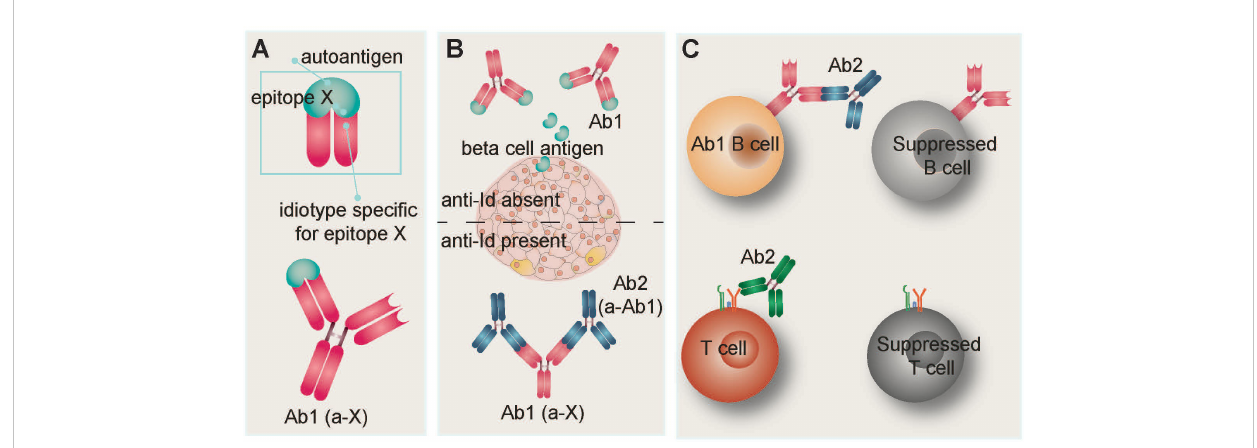
FIGURE 3 Idiotypic/anti-idiotypic network hypothesis. (A) The antigen binding site of an antibody is referred to as the idiotope. Idiotypic antibody Ab1 recognizes and binds epitope X on autoantigen X. In T1D, autoantigen X is frequently a beta cell protein such as insulin, glutamic acid decarboxylase (GAD), or tyrosine phosphatase-related insulinoma-associated 2 molecule (IA-2). Detection of T1D-associated autoantibodies is routinely used as a diagnostic indicator of disease. (B) The idiotypic network postulates that antibodies can be raised against the idiotope of Ab1. In the context of autoimmunity, these anti-idiotypic (anti-Id) antibodies (Ab2) compete with autoantigen X for binding sites on Ab1, resulting in Ab1 neutralization and limiting antibody-mediated damage to target cells. Anti-Id antibodies have been detected in healthy individuals and T1D patients, but are not routinely measured. (C) During the neonatal period, binding of anti-Id Ab2 to the B cell receptor of Ab1-bearing B lymphocytes leads to their suppression. Similarly, anti-Id antibodies can suppress T lymphocytes via binding to their T cell